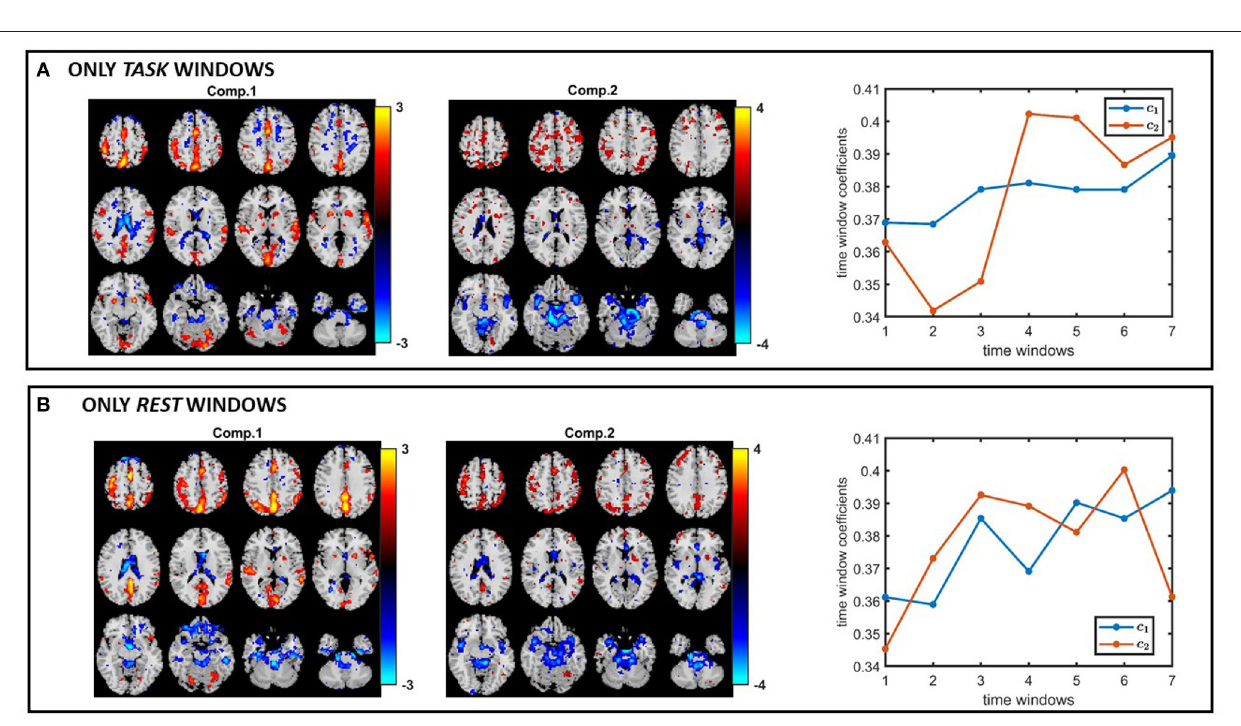
FIGURE 13 | PARAFAC2 analysis of (A) only task windows: Spatial components, i.e., columns of B k , for k = 1, as well as the temporal patterns, i.e., columns of C . The p -values are 2.1 × 10 − 4 for component 1, and 2.7 × 10 − 1 for component 2. (B) Only rest windows: Spatial components, i.e., columns of B k , for k = 1, as well as the temporal patterns, i.e., columns of C . The p -values are 6.6 × 10 − 3 for component 1, and 8.5 × 10 − 1 for component 2. The first component shows statistical significance in terms of group difference in both task and rest windows; therefore, supporting the modeling assumptions of PARAFAC2 and joint ICA. Spatial maps are plotted using the patterns from the voxels mode as z-maps and thresholding at | z | ≥ 1.5 such that red voxels indicate an increase in controls over patients, and blue voxels indicate an increase in patients over